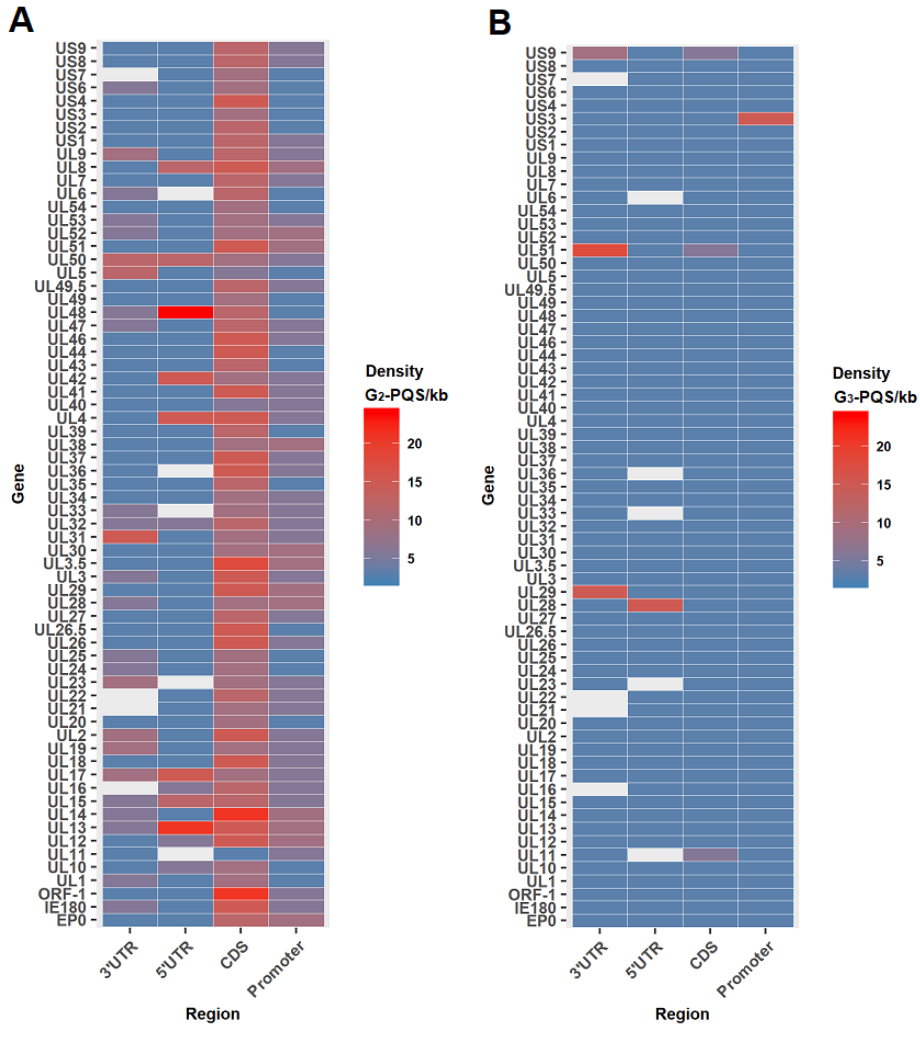
Figure 6. Heat maps of PQS density in coding sequence and regulatory regions of each PRV gene. ( A ) Heat map of G 2 -PQSs; ( B ) Heat map of G 3 -PQSs.